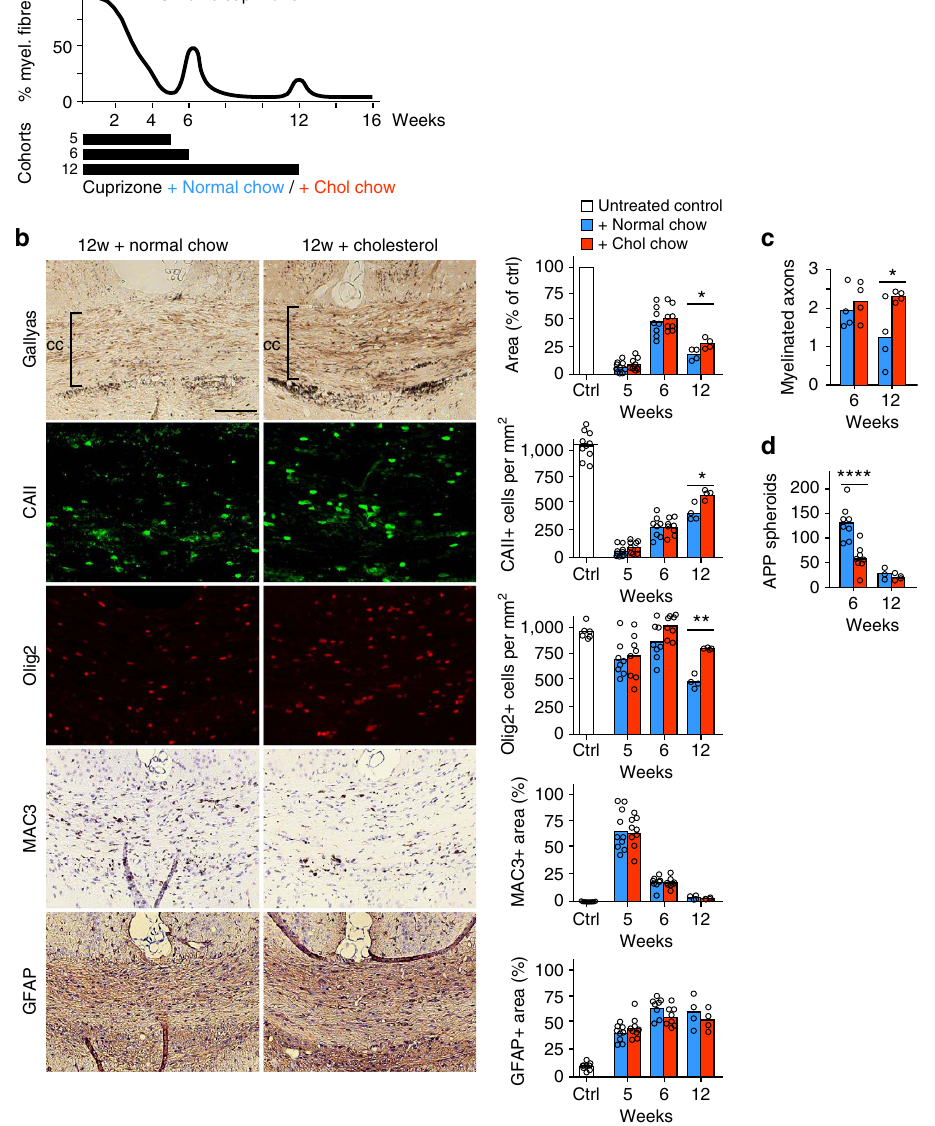
Figure 4 | Cholesterol facilitates remyelination after chronic cuprizone exposure. ( a ) Scheme depicting the time course of demyelination/remyelination during cuprizone feeding to the treatment paradigm. To assess the influence of high-cholesterol feeding on spontaneous remyelination, mice received cuprizone in normal chow or chow supplemented with cholesterol for 5, 6 or 12 weeks (black bars) after which mice were analysed histologically. ( b ) Evaluation of disease in the corpus callosum of mice that were treated with cuprizone for 5, 6 or 12 weeks on normal chow or chow enriched with cholesterol. Corresponding representative pictures of the 12 weeks treatment cohort are on the left. Assessed were myelination (Gallyas silver impregnation), the number of mature oligodendrocytes (CAII), the number of oligodendrocyte lineage cells (Olig2), activated microglia (MAC3) and astrocytes (GFAP). Each bar represents the mean value of 4 (week 12) or 8–10 (week 5, 6) animals per condition with individual data points (scale 100 m